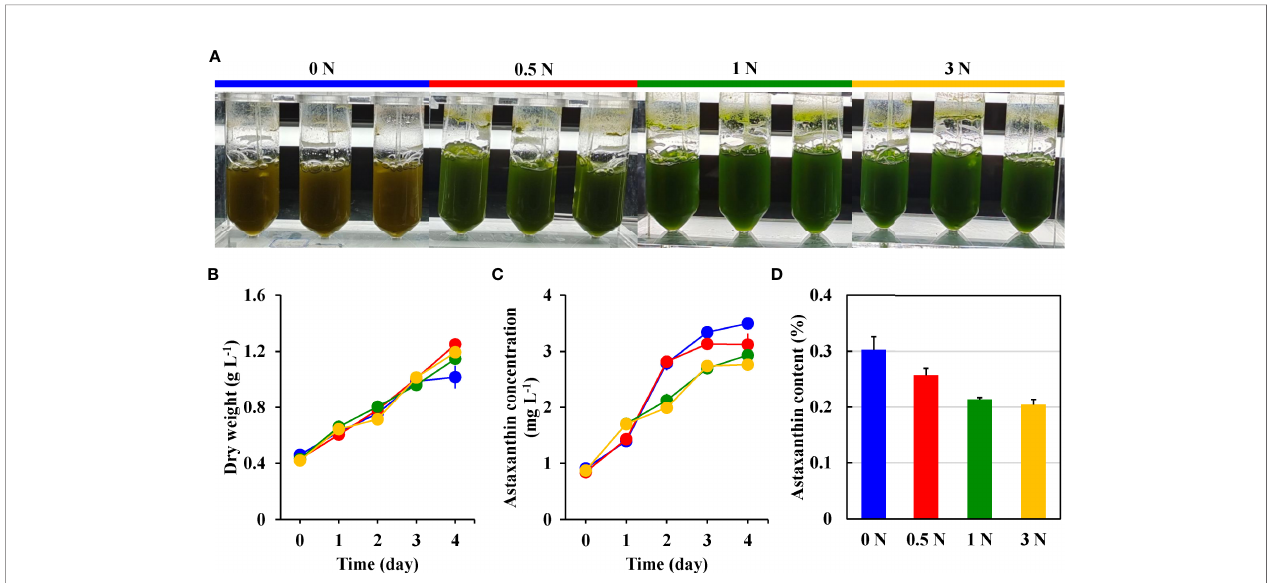
FIGURE 1 | The color changes (A) , dry weight (B) , astaxanthin concentration (C) , and astaxanthin content (D) of H. pluvialis motile cells in the 0 N (blue), 0.5 N (red), 1 N (green), and 3 N (yellow)